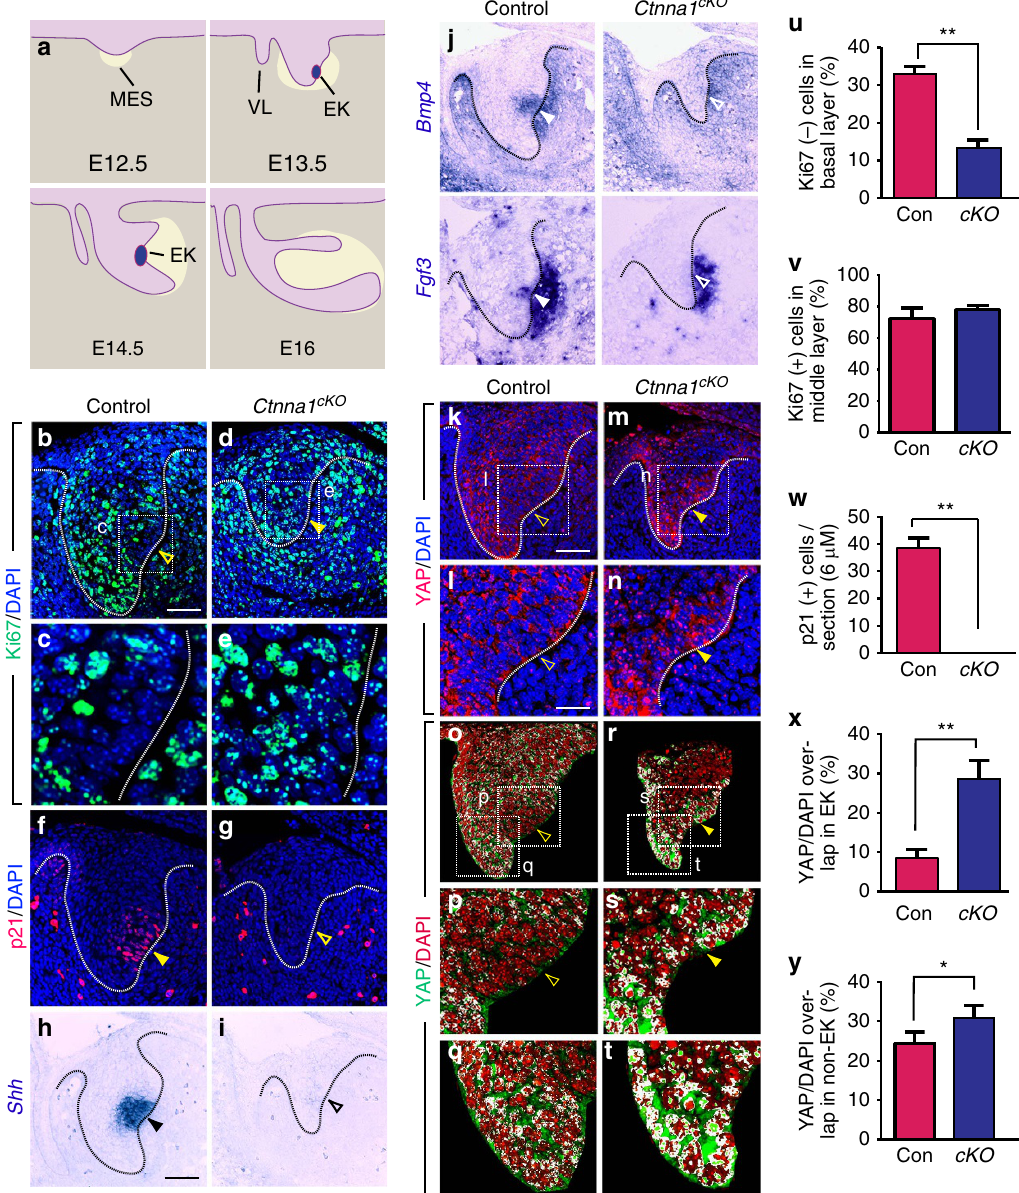
Figure 1 | Deletion of Ctnna1 induces YAP nuclear localization as well as cell proliferation and inhibits EK formation. ( a ) Schematic diagram of incisor morphogenesis. At E12.5, the dental epithelium (light purple) begins to invaginate into the underlying mesenchyme (MES, tan). By E13.5, the EK is formed. Subsequent epithelial-mesenchymal interactions result in mesenchymal condensation around the epithelium (yellow shaded area). At E14.5, the epithelium turns posteriorly, and the EK regresses by E16. ( b , c ) At E13.5, the EK consists of post-mitotic cells that are Ki67 negative (open yellow arrowhead). ( d , e ) Ablation of Ctnna1 ( Ctnna1 cKO ) by K14Cre results in ectopic cell proliferation in this region (yellow arrowhead in c ). ( f , g ) p21 is expressed in the control EK (yellow arrowhead) but not in Ctnna1 cKO (compare yellow arrowhead in f to open yellow arrowhead in g ). ( h – j ) EK markers, Shh , Bmp4 and Fgf3 , are absent in the Ctnna1 cKO (compare black arrowhead in h and white arrowheads in j to open black arrowhead in i and open white arrowheads in j ). Mesenchymal Bmp4 and Fgf3 are also reduced. ( k , l , o – q ) At E13.5, the EK contains mostly cytoplasmic YAP (open yellow arrowheads in k , l ), while strong nuclear YAP staining is detected in the surrounding epithelium ( q ). This is visualized through detection of overlapping signals (white) between YAP (green) and DAPI (red) (open yellow arrowheads in o , p ). ( m , n , r – t ) Deletion of Ctnna1 results in YAP nuclear localization in the presumptive EK (yellow arrowheads in m , n , r , s ) and the neighbouring epithelium ( t ). ( u , v ) Quantification of Ki67-negative ( (cid:2) ) cells in the basal layer ( u ) and Ki67-positive ( þ ) cells in the area surrounding the EK ( v ) at E13.5 (mean ± s.e.m., n ¼ 3, P o 0.01). ( w ) Quantification of p21-positive ( þ ) cells in control and Ctnna1 cKO (mean ± s.e.m., n ¼ 3, P o 0.01). ( x , y ) Quantification of nuclear YAP in the EK region ( x ) and in the protruding epithelium ( y ) in control and Ctnna1 cKO (mean ± s.e.m., n ¼ 4, P o 0.01 and 0.05 respectively). All quantifications are analysed by using Student’s t -test. * P o 0.05, ** P o 0.01. Dotted lines outline the epithelium of the incisor tooth germ. VL, vestibular lamina. Scale bar, 25 m m ( b , d , f , g , k , m , o , r ); 12 m m ( l , n , p , q , s , t ); 8 m m ( c , e ) 50 m m ( h , i , j ). NATURE COMMUNICATIONS|7:12133|DOI: